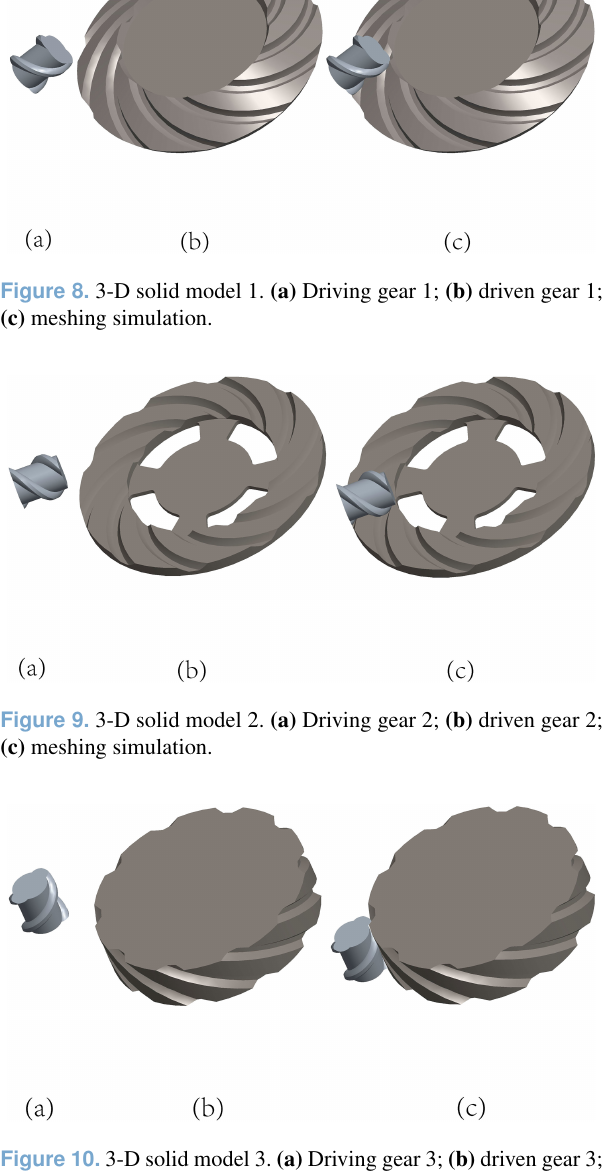
Table 1. Parameters of three line gear pairs.